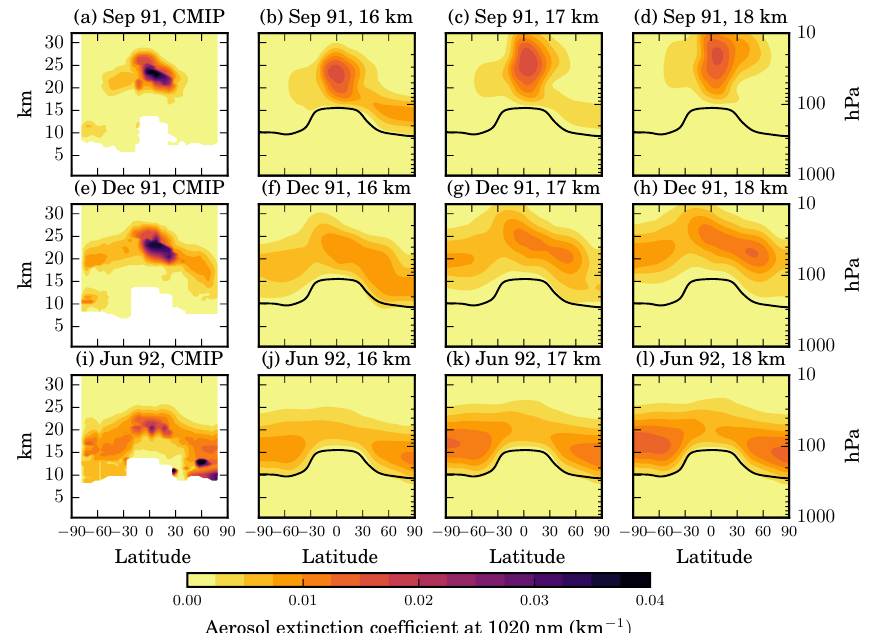
Figure 7. Temporal evolution of the zonal mean aerosol extinction coefficient (km − 1 ) at 1020nm. Monthly mean latitude–height distributions in September 1991 (first row), December 1991 (second row), and June 1992 (third row). Observation-based CMIP6 aerosol data set (first column), and simulations with emission of SO 2 at 16km (second column), 17km (third column), and 18km (fourth column). The vertical axis shows the height in km and the black line indicates the modelled